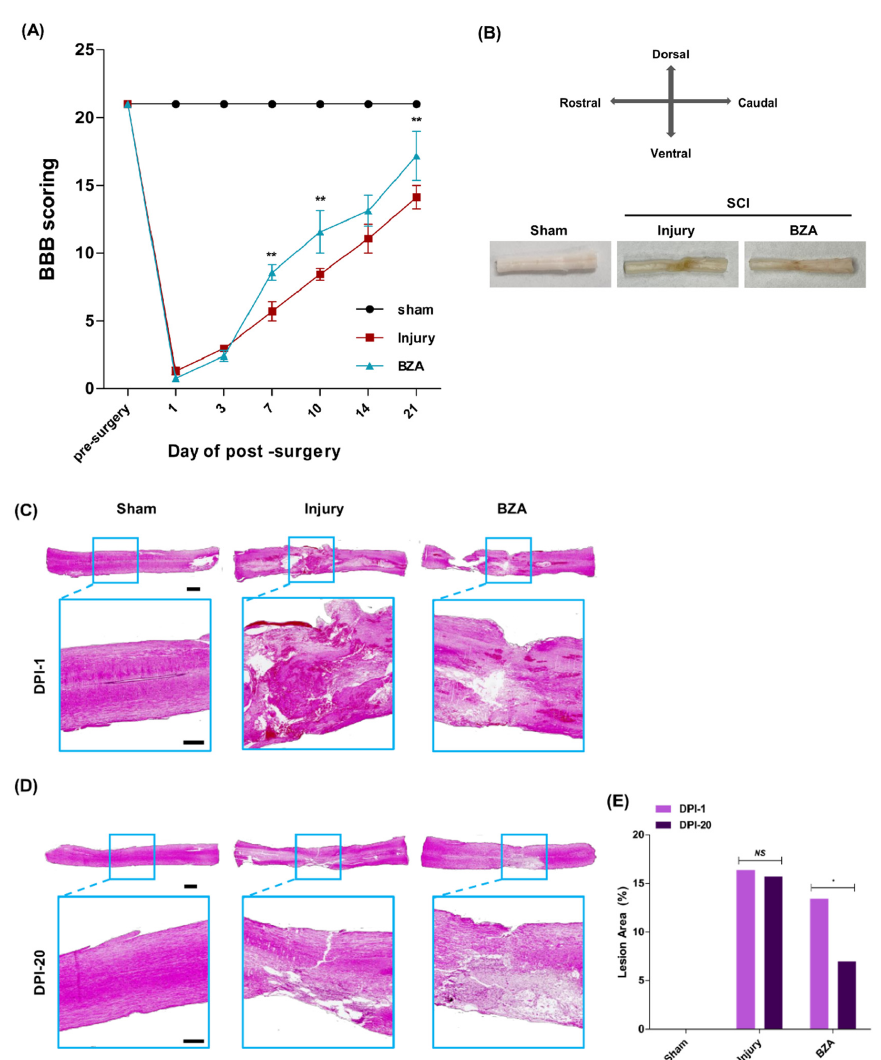
Figure 7. BZA reduces lesion volume and improves functional recovery following SCI in vivo . ( A ) Locomotor functional recovery evaluation using BBB scores. The BZA-treated group had significantly higher BBB scores compared with the injury-only group. ( B ) Gross morphology at 21 days after SCI showed better tissue preservation in the BZA-treated group. Representative images of hematoxylin and eosin (H&E) staining at dpi 1 ( C ) and dpi 20 ( D ) and quantitative analys© ( E ) showed reduced tissue necrosis area in the BZA-treated group. Data represent mean ± SEM ( n = 3( C – E ). Data represent mean ± SD ( n = 3–6 ( A ); performed by two blinded reviewers with BBB scoring). * p < 0.05, ** p < 0.01 (dpi 1 vs. dpi 20, same group ( C ), injury vs. BZA ( D ), NS = Not significant, Student t test followed by the Mann Whitney test for H&E lesion area percentage and two-way ANOVA followed by the Bonferroni test for BBB